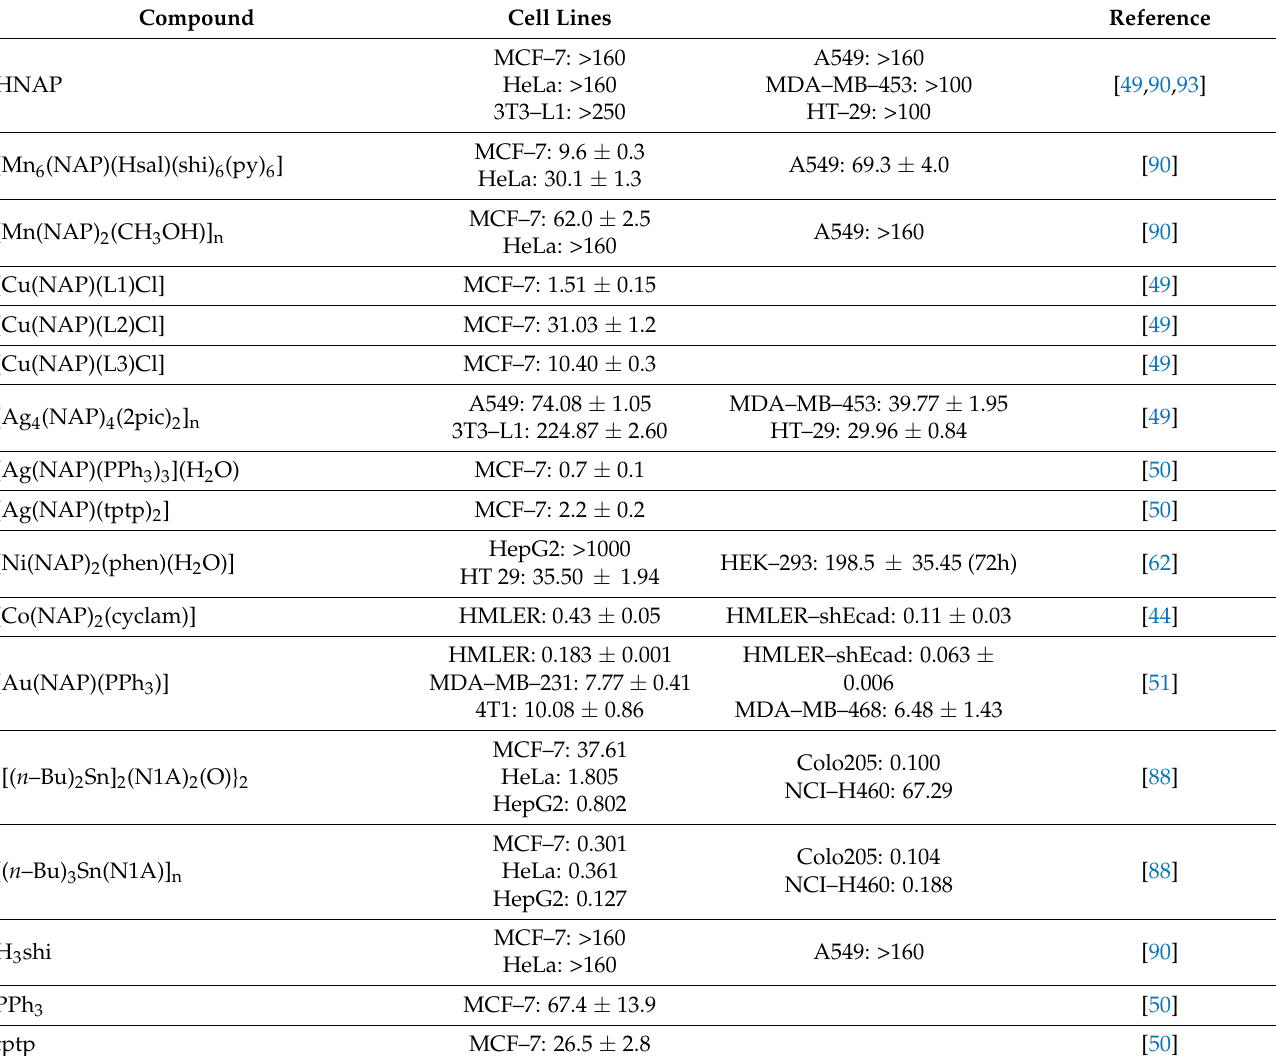
Table 10. In vitro cytotoxicity of reported compounds (IC 50 , in µ M) against diverse cancer cell lines and normal cells (3T3–L1) after treatment for 48